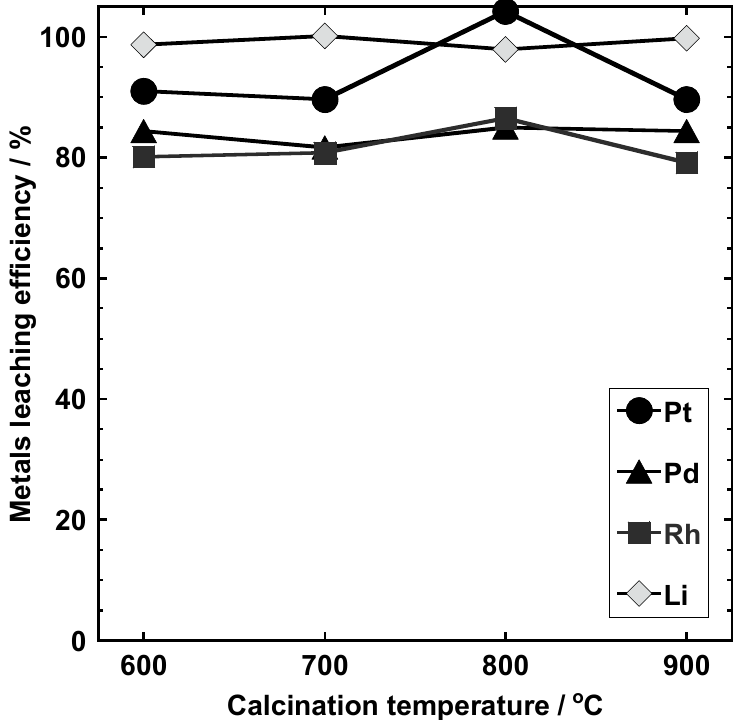
Figure 10. Pt, Pd, Rh, and Li leaching efficiencies of the samples obtained under conditions I-D-1, I-D-2, I-D-3, and I-D-4.